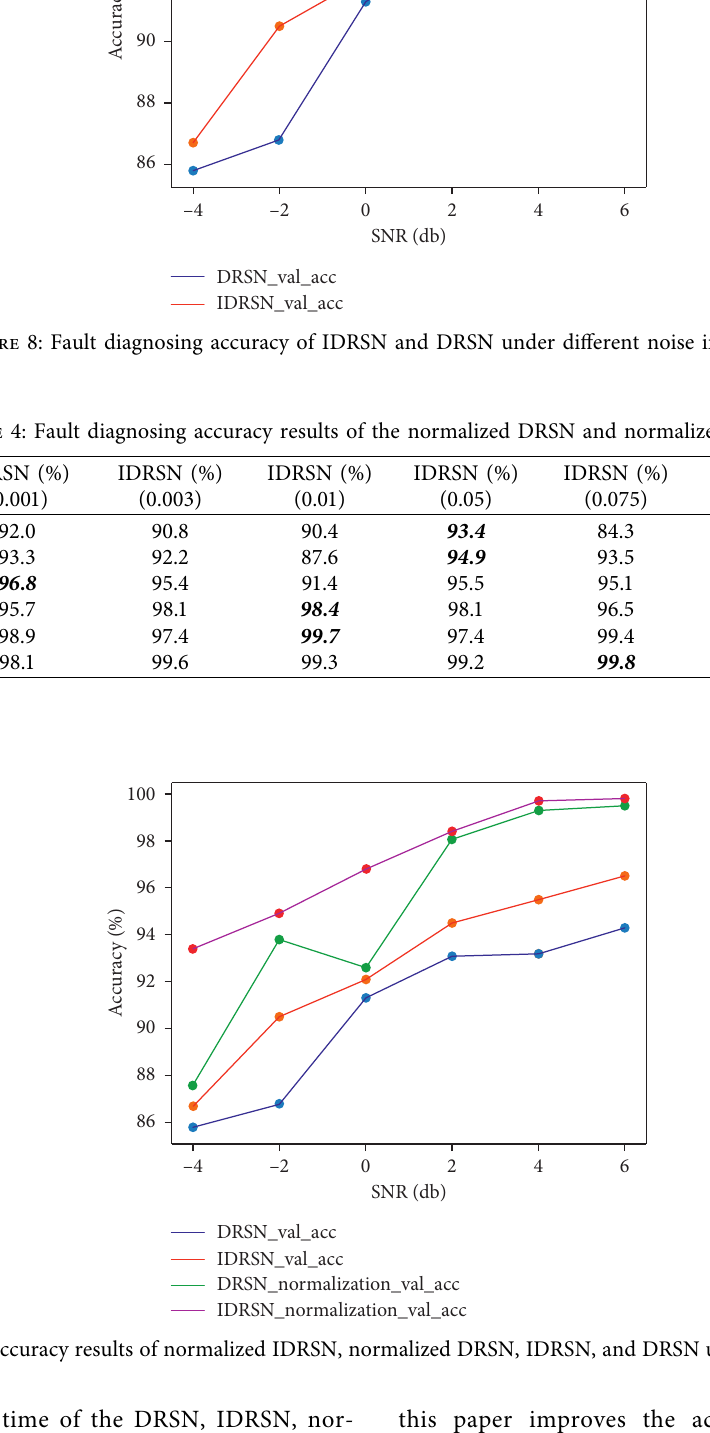
this paper improves the accuracy of fault diagnosis without increasing the computational complexity of the model.